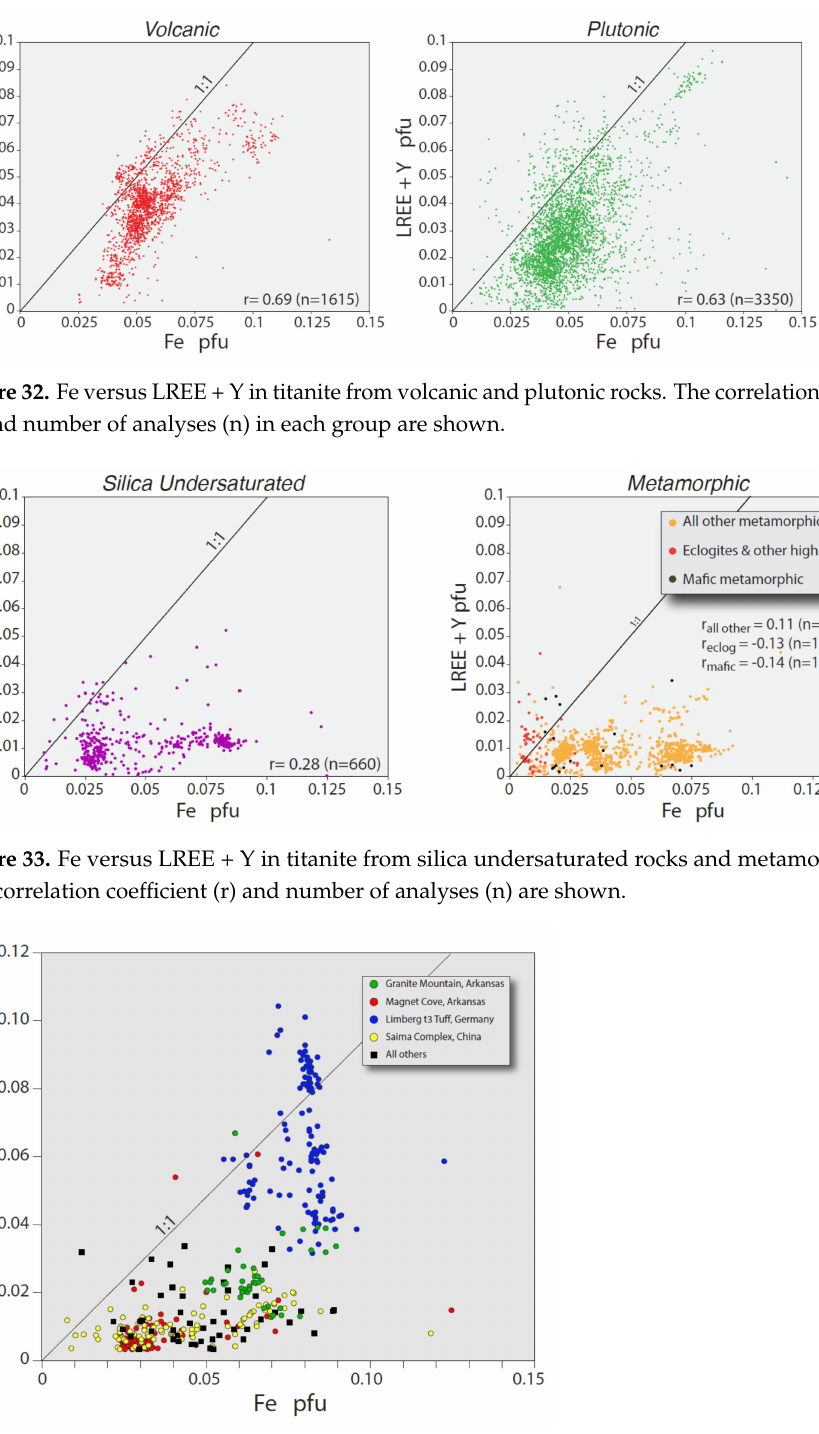
Figure 34. Fe versus Nb in titanite from silica-undersaturated rocks plotted as atoms per formula unit (pfu). A general positive correlation of Nb and Fe suggests a coupled substitution for charge balancing in the Ti